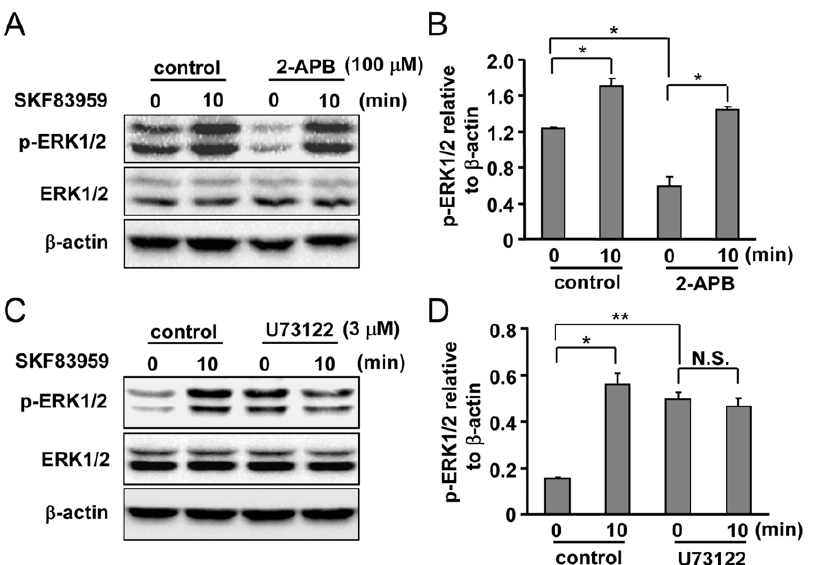
Figure 4. Roles of PLC and IP3 receptor in the mediation of SKF83959-induced ERK1/2 phosphorylation. (A) Representative Western blot results indicating the effects of 2-APB (100 m M, 30 min) on SKF83959 (30 m M, 10 min)-induced ERK1/2 phosphorylation. (B) Quantitative analysis of pretreatment with 2-APB on SKF83959-induced ERK1/2 phosphorylation (Mean 6 S.E., n=3, * P , 0.05, 10 min vs. 0 min, * P , 0.05, 2-APB 0 min vs. control 0 min). (C) Representative Western blot results showing the effects of U73122 (3 m M, 30 min) on SKF83959 (30 m M, 10 min)-induced ERK1/2 phosphorylation. (D) Quantitative analysis of pretreatment with U73122 on SKF83959-induced ERK1/2 phosphorylation (Mean 6 S.E., n=3, * P , 0.05, 10 min vs. 0 min, ** P , 0.01, U73122 0 min vs. control 0 min). N.S.: no significance.